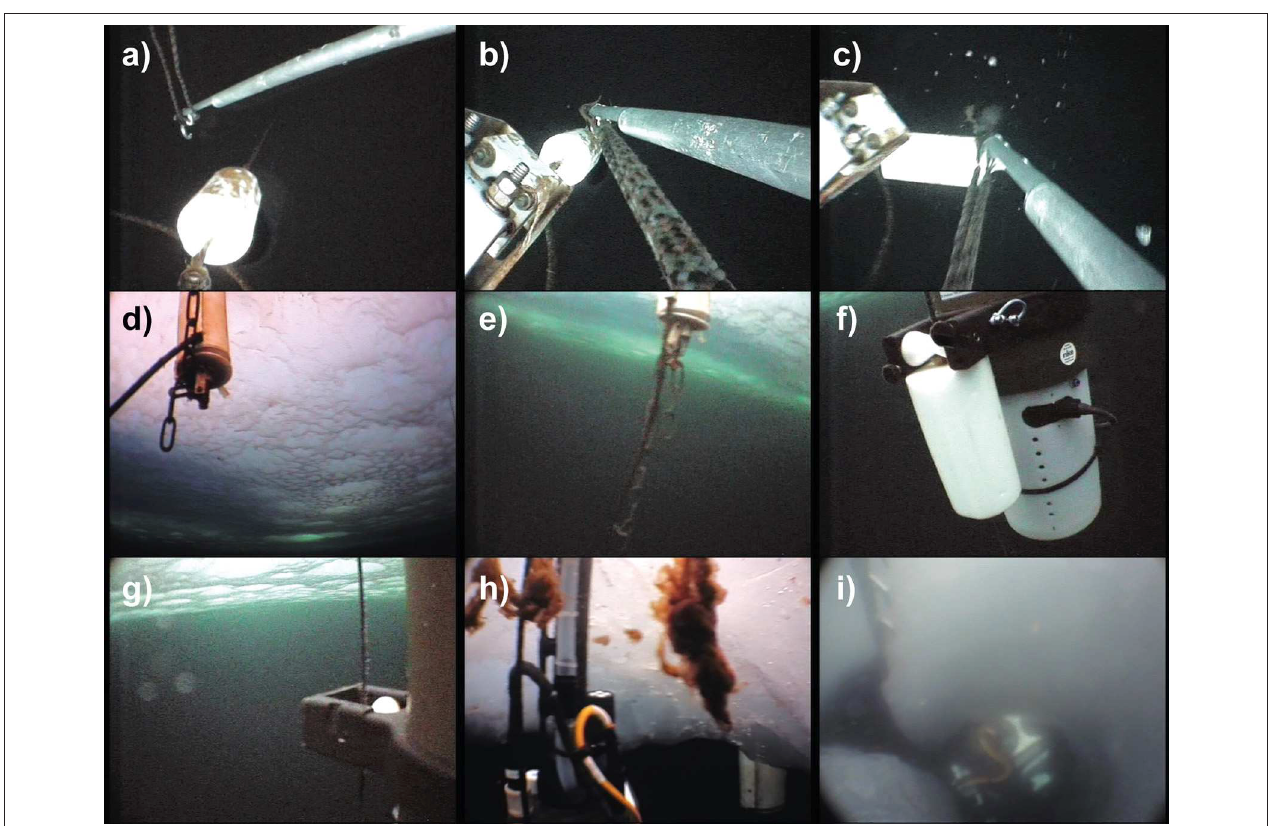
FIGURE 3 | Screenshots taken from the underwater camera during recovery work: (a) Clipping a biner with rope loop into the wire below the top stop. (b) After the biner is clipped into the wire. (c) Taking the load onto the initial recovery system. (d) The attachment chain is fully stretched and pointing upwards, while the umbilical leading to the inductive modem was already cut. (e) After removal of the wire and inductive modem, the chain, and umbilical hang down straight again. (f) Profiler resting on the bottom stop during recovery. (g) Profiler attachment to wire, note the algal contamination on wire. (h) profiler underneath the recovery hole. The floating algal flocks result from biofouling on the wire stripped off by the friction knot. (i) Removing the last ice nose prohibiting profiler recovery with the ice saw (top left image corner). The bright white buoyancy pack of the profiler is already visible under the